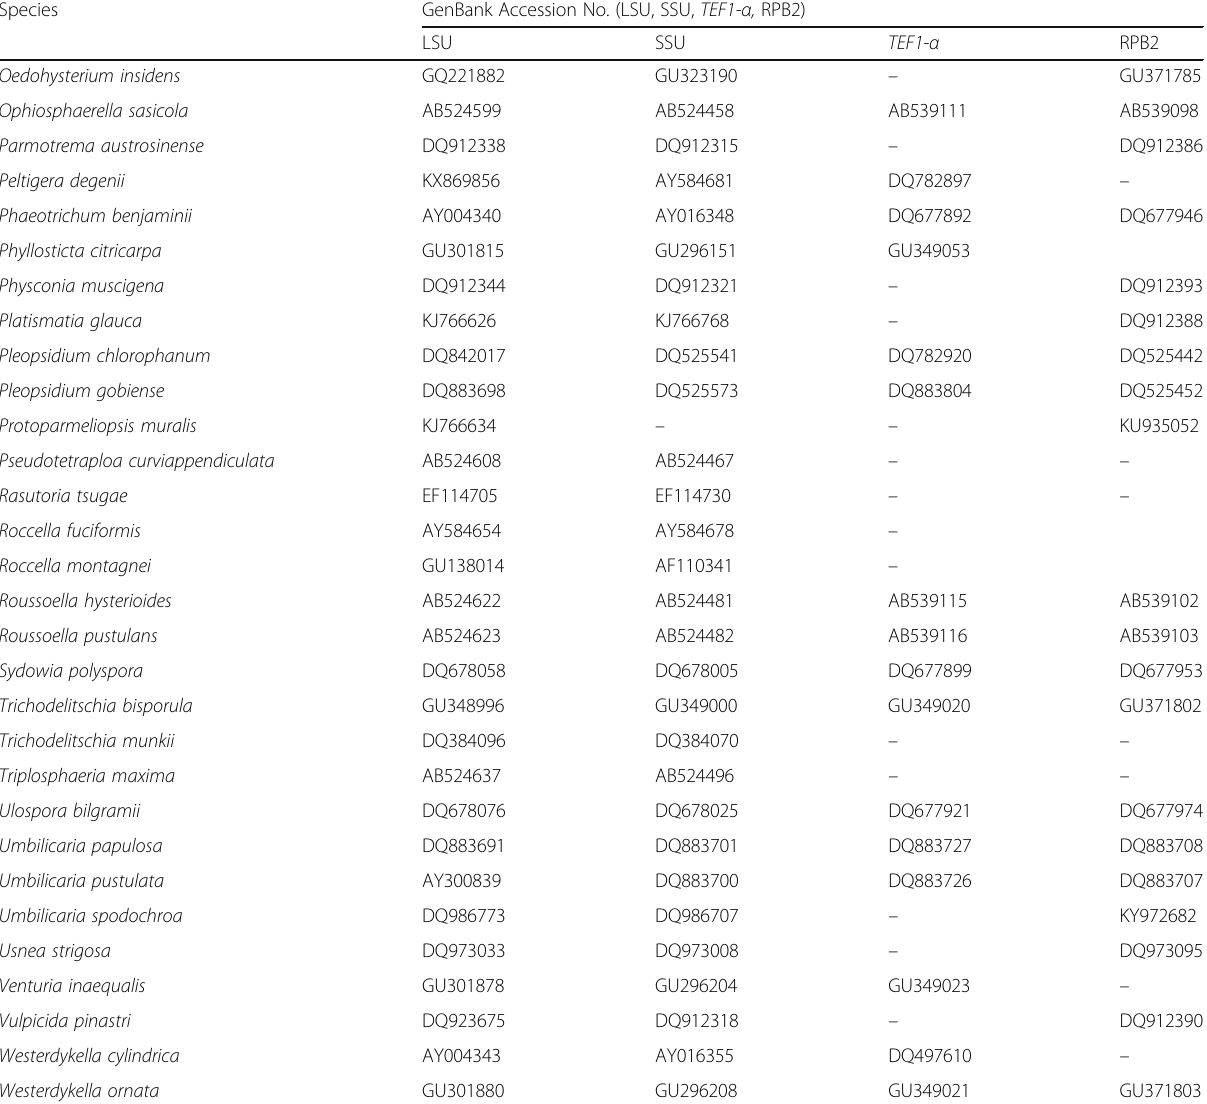
Table 3 Other sequences retrieved from GenBank for phylogenetic analysis (Continued)